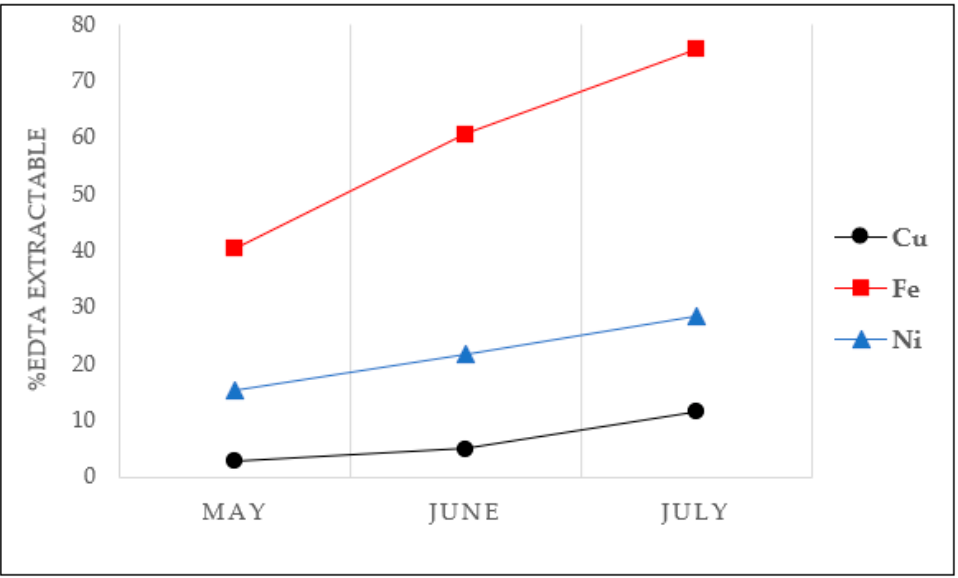
Figure 3. EDTA extractable Cu, Fe, and Ni in nickel flotation feed samples taken from the Kevitsa plant.